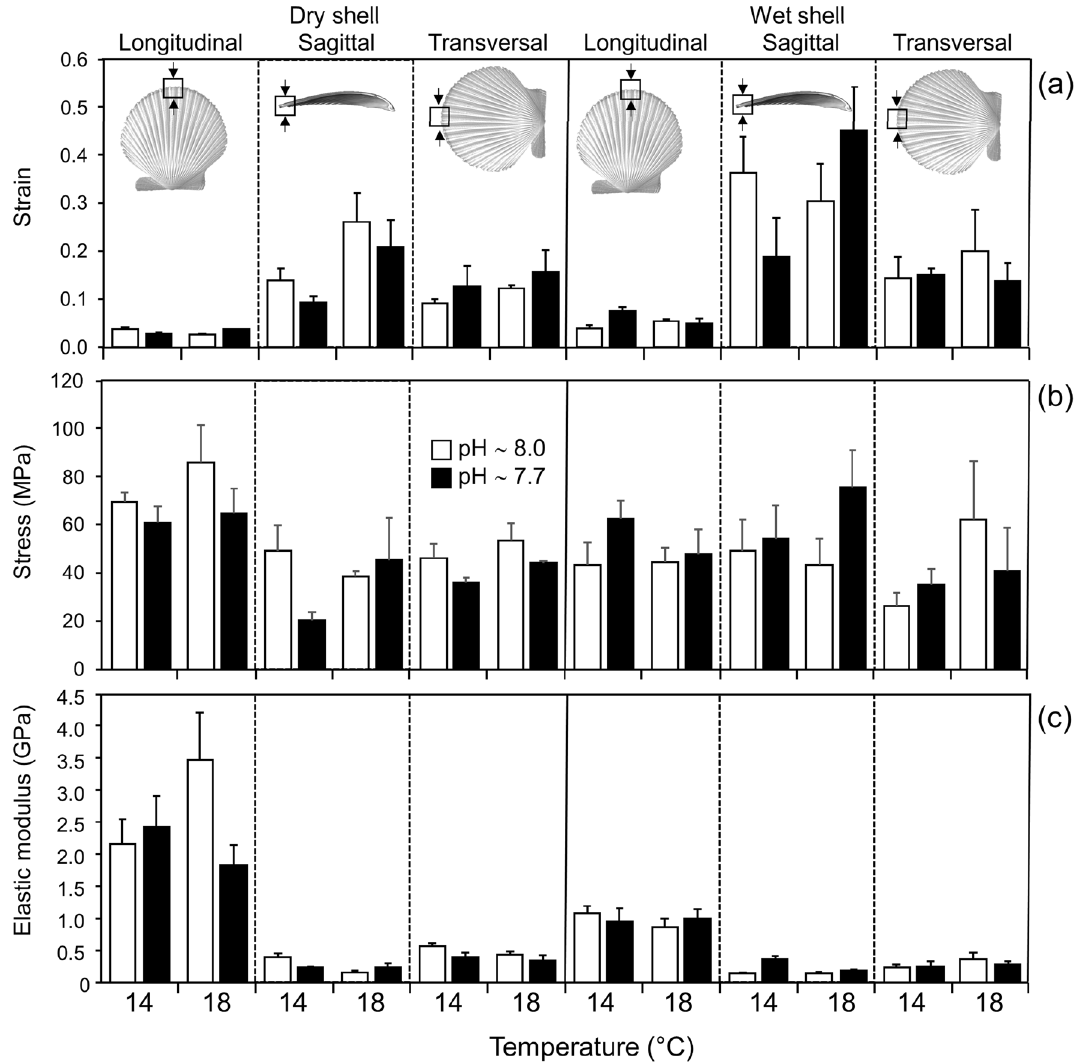
Figure 5. Influence of temperature and pH on Argopecten purpuratus shell biomechanical properties. Compression test (mean ± SE.) performed on A. purpuratus at the growing edge of the shells under dry and wet conditions and along three main orientation planes of the